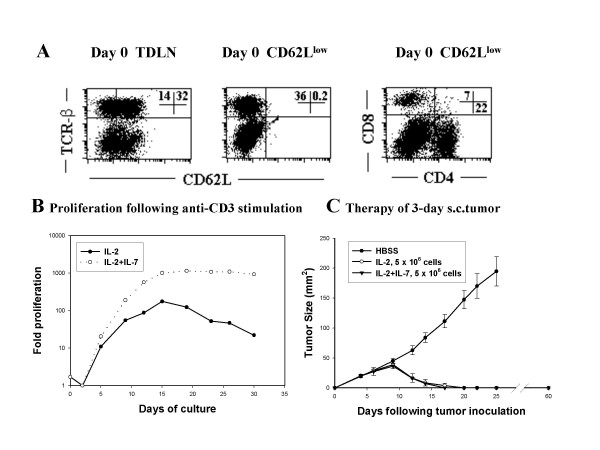
Proliferation and efficacy of CD62Llow TDLN cells cultured with IL-2 +/- IL-7. (A) Freshly isolated whole TDLN cells were stained for expression of TCR and CD62L (left panel). The purified CD62Llow subset was stained for TCR and CD62L expression (center panel), or for CD4 and CD8 expression (right panel). (B) CD62Llow TDLN cells were activated with immobilized anti-CD3 mAb for 2 days then cultured in medium with IL-2 (4 U/ml) (closed circle) or the combination of IL-2 and IL-7 (10 ng/ml) (open circle). Cells density was adjusted to 105/ml on days 5 and 9 and total proliferation was calculated. (C) Mice bearing 3-day s.c tumors were treated with 5 Gy TBI then received adoptive transfer of 5 × 106 T cells cultured for 9 days with IL-2 alone (open circle), IL-2 + IL-7 (open triangle), or HBSS (closed circle). Each treatment group is significantly different than HBSS control (P < 0.01).